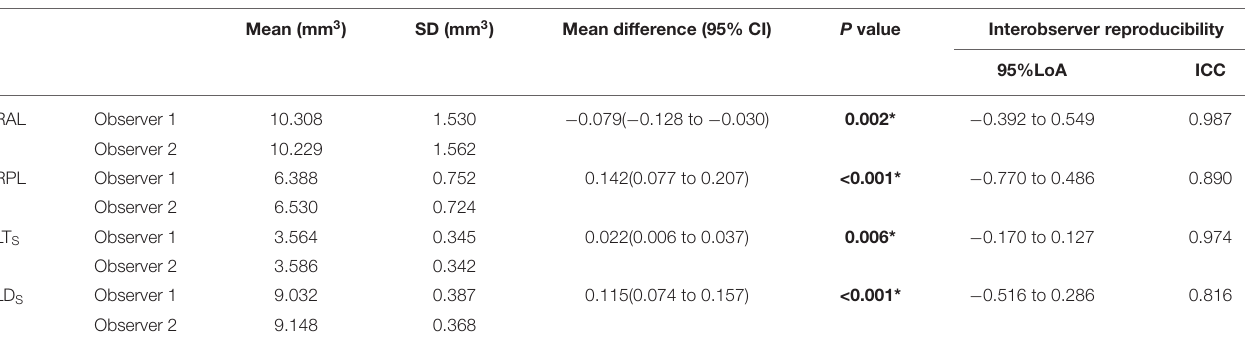
TABLE 1 | Interobserver reproducibility of lens biometry measurements with Insight